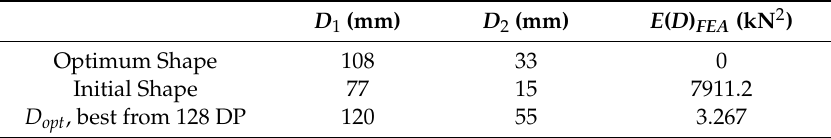
Table 1. Calculated cost function value in di ff erent design points.